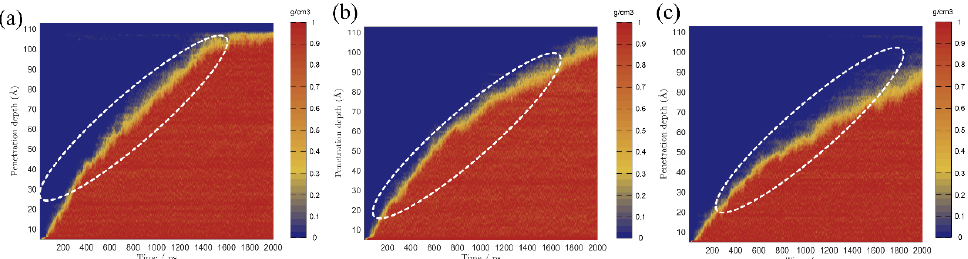
Figure 4. Percolation depth maps of different solutions in C ‐ S ‐ H gel channel without TIA: ( a ) man ‐ ifests water solution, ( b ) demonstrates NaCl solution, ( c ) represents Na 2 SO 4 solution.